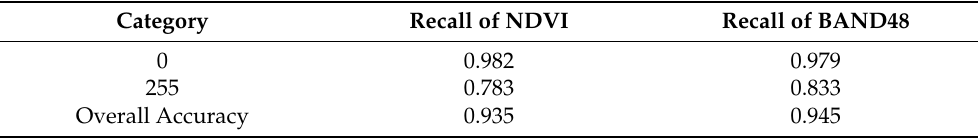
Table 8. Quantitative comparison results of vegetation extraction from the Pavia Center data set.